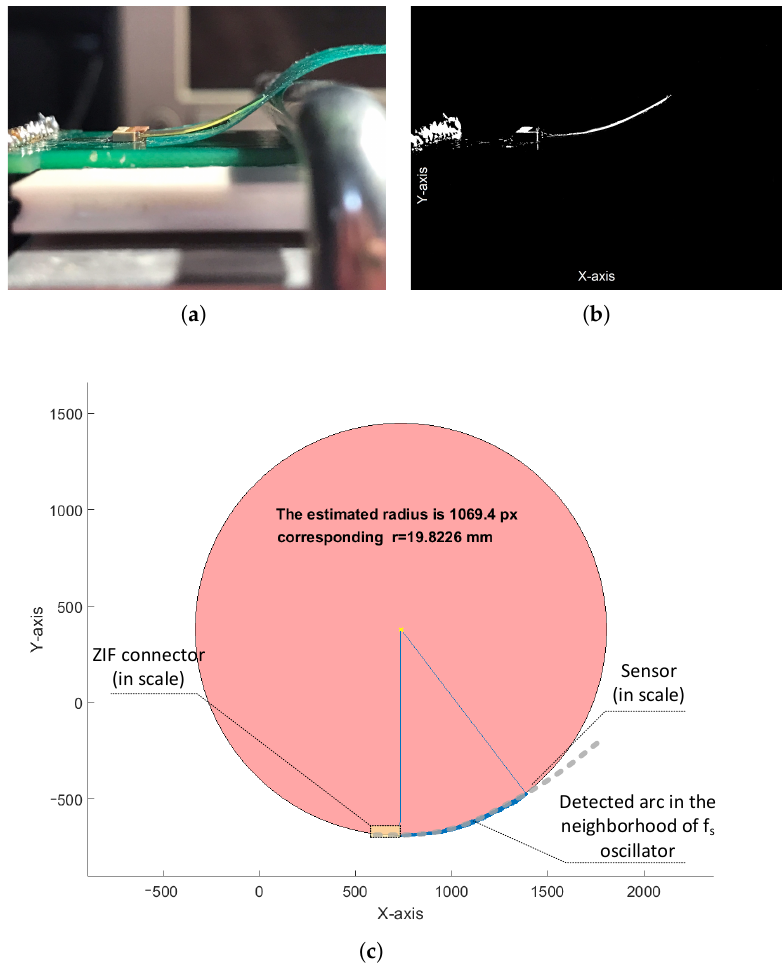
Figure 16. Arc detection algorithm (image processing) used in the radius estimation: test bench ( a ), picture after the edge detection ( b ), and ( c ) automated circle approximation (the sensor and ZIF connector are also marked in scale for greater